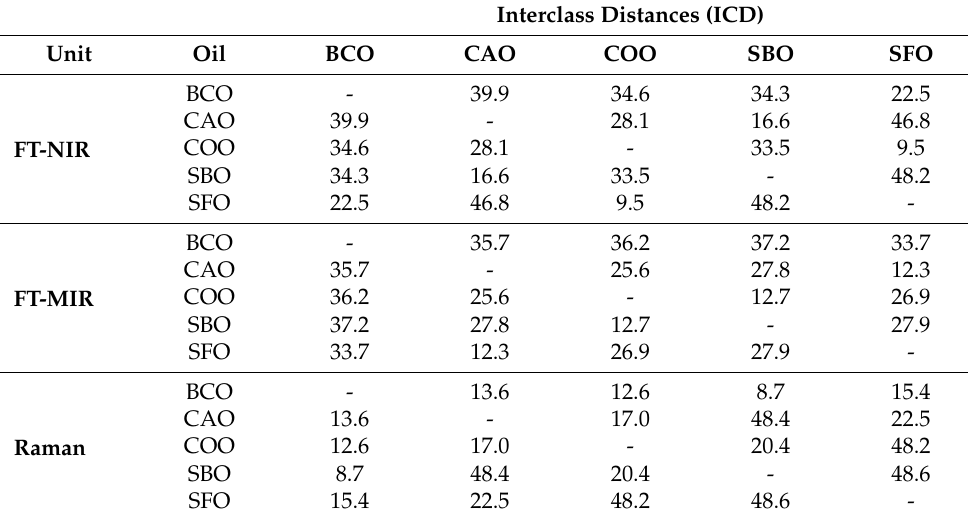
Table 2. Interclass distances obtained from SIMCA